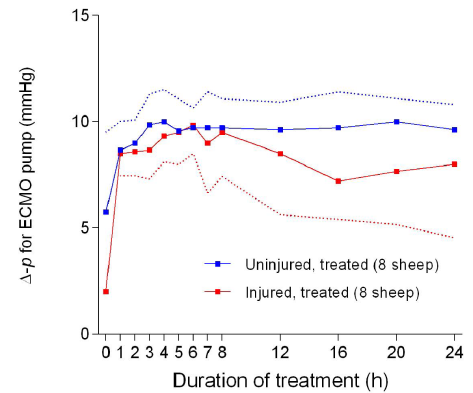
Figure 48. Pressure differential ( Δ -p) (Mean ± SD) across the extracorporeal life support pump for smoke and non-smoke injured sheep that received treatment. Dotted lines represent one- sided error